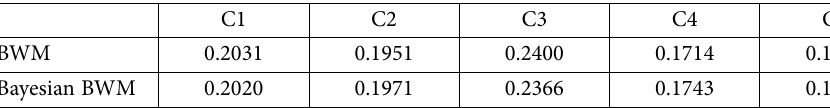
Table 5. External